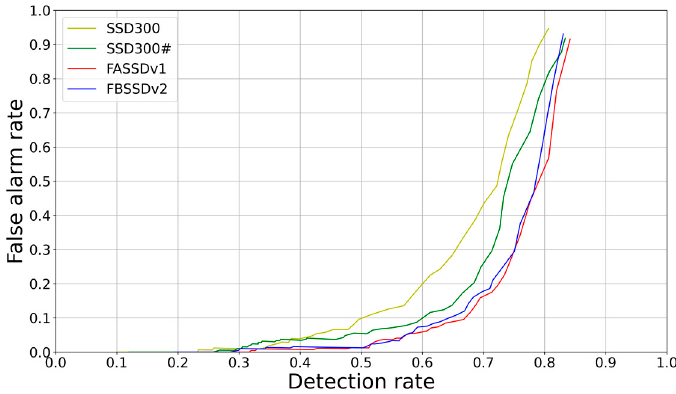
Figure 6. Curves of detection rate and false alarm rate.